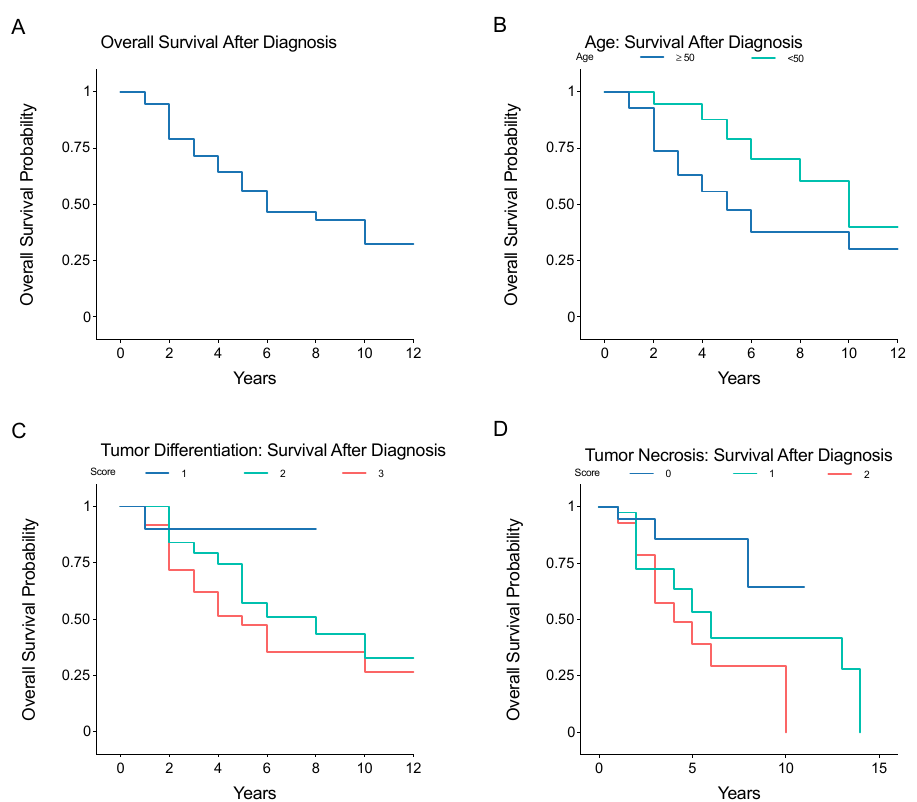
Figure 2. Kaplan–Meier analysis of overall survival, stratified by tumor grade I, II, or III, after initial diagnosis of localized LMS. ( A ) overall survival, and survival stratified by ( B ) age greater or less than 50 years, ( C ) pathologist-reported tumor differentiation score (1, 2, or 3), or ( D ) pathologist-reported tumor necrosis score (0, 1, or 2). Table 3. Multivariate Analysis of Prognostic Factors for Overall Survival. * indicate significant results, p-value < 0.05.